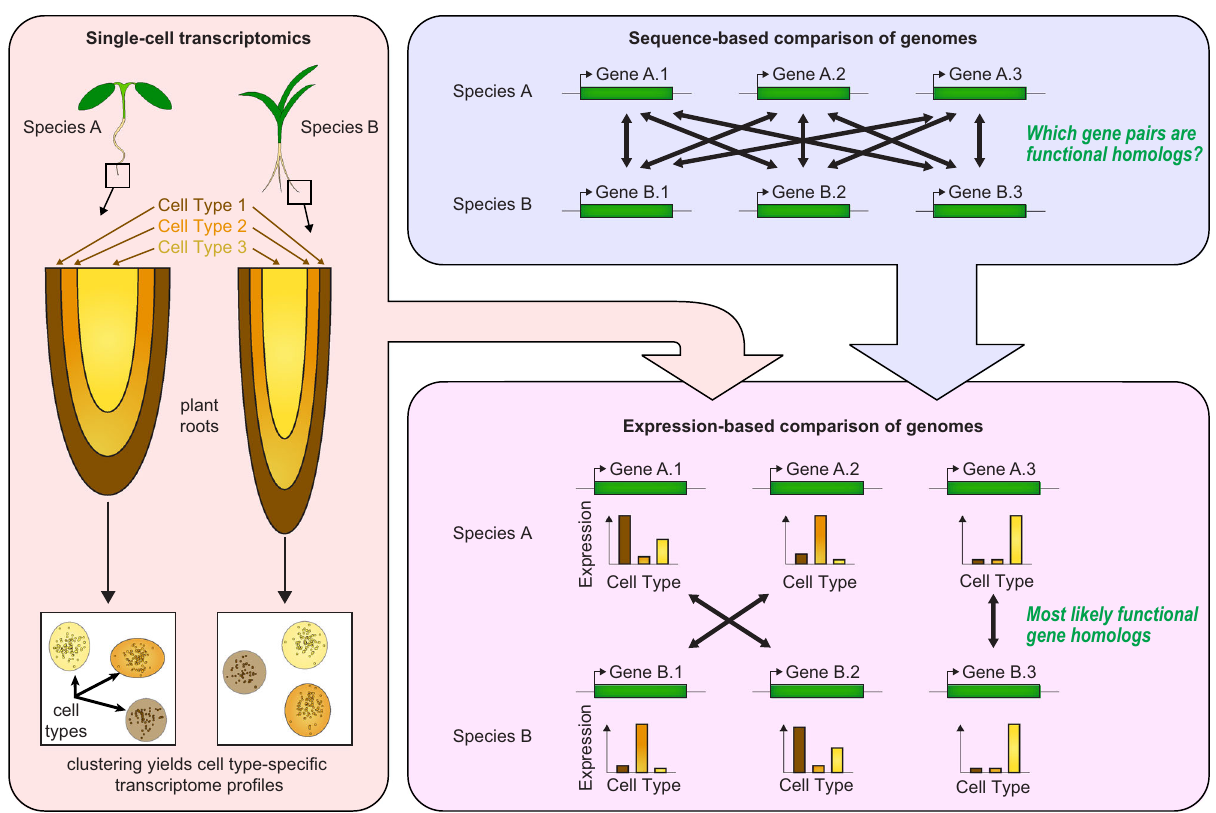
Fig. 3 Using single-cell transcriptome data to improve the comparative annotation of plant genomes. Expression pro fi les across multiple cell types derived from single-cell transcriptome data of tissues from different plant species (left), in combination with sequence homology-based comparison of protein sequences (top right), can be used to identify functionally homologous genes across different plant species (bottom right), thereby substantially enhancing the ability to assign functional knowledge from deeply annotated model species correctly to other species that are of interest to bioenergy and biomaterial